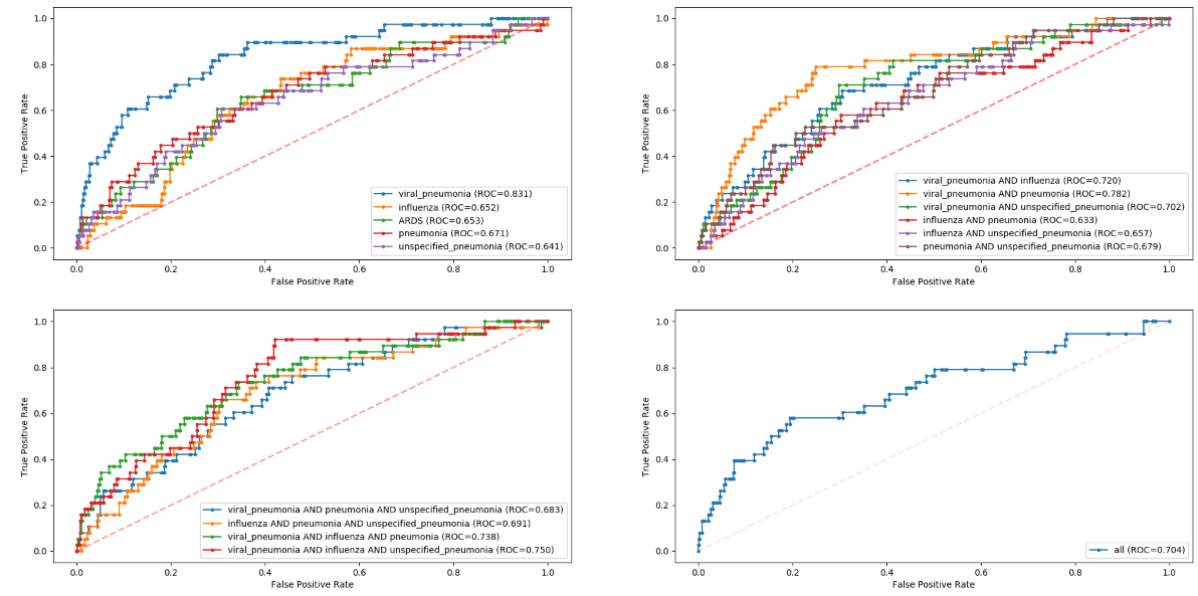
Figure 2. Receiver operating characteristic curves for model performance on predicting 48-hour invasive mechanical ventilation risk in the COVID-19 cohort, stratified by COVID-19–like cohorts. ARDS: acute respiratory distress syndrome; ROC: receiver operating